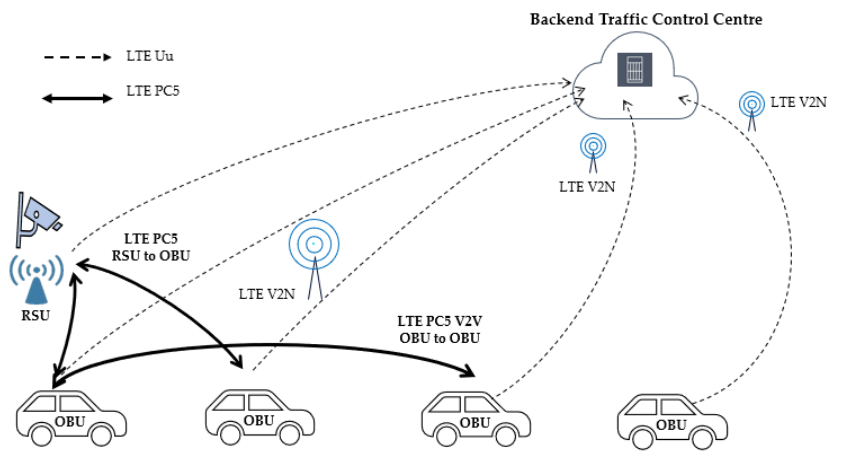
Figure 9. C-V2X Network Topology.